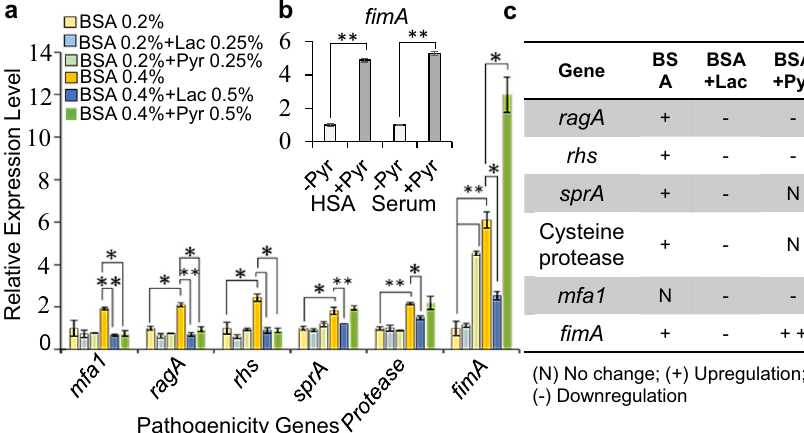
Fig. 3 Various pathogenicity genes are differentially expressed in response to the availability of speci fi c energy substrates, i.e., pyruvate or lactate and/or serum components. a RT-qPCR analysis and relative expression levels shows that, consistent with bio fi lm results, BSA utilization increases the expression of fi mA in a concentration-dependent manner; the addition of pyruvate in the BSA-based medium remarkably increases the expression of fi mA . In addition, the provision of higher concentrations of BSA correlates positively with the expression of those pathogenicity genes involved in the degradation of protein substrates and oligopeptide uptake. Exogenous lactate signi fi cantly decreases the expression of fi mA and other pathogenicity genes when compared with untreated controls, leading to decreased bio fi lm formation. b The addition of pyruvate in HSA or human serum also signi fi cantly increases the expression of fi mA . c Table summarizes RT-qPCR results and shows the correlation of utilized energy substrates and expression of pathogenicity genes. Graphs represent mean expression ± SE (two biological replicates, in each n = 3). Asterisks indicate pairs of signi fi cantly different values (post hoc Tukey ’ s HSD test: * p < 0.05; ** p <